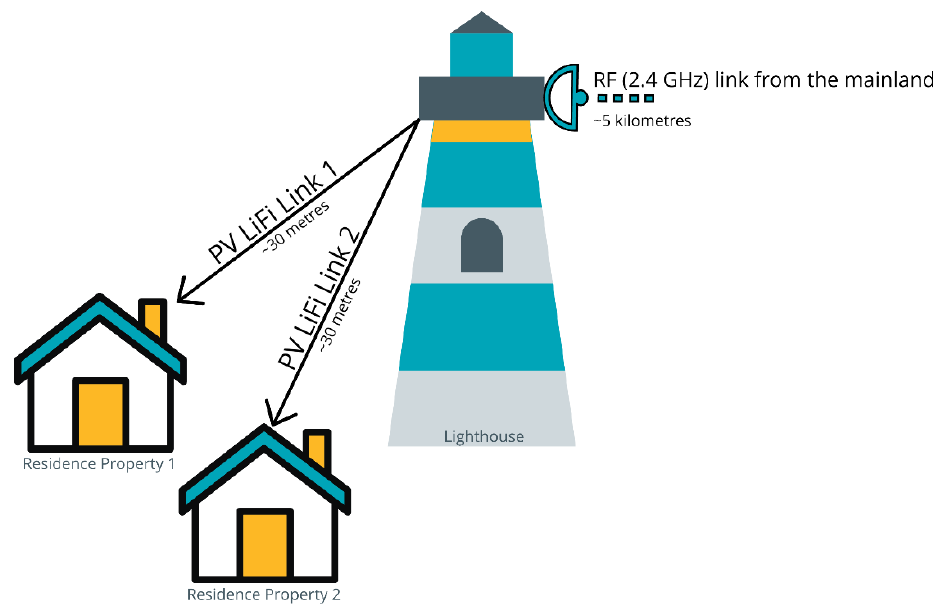
Figure 1. Deployment architecture.